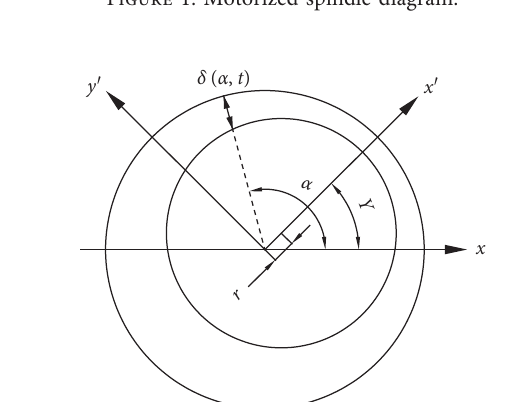
Figure 1: Motorized spindle diagram.